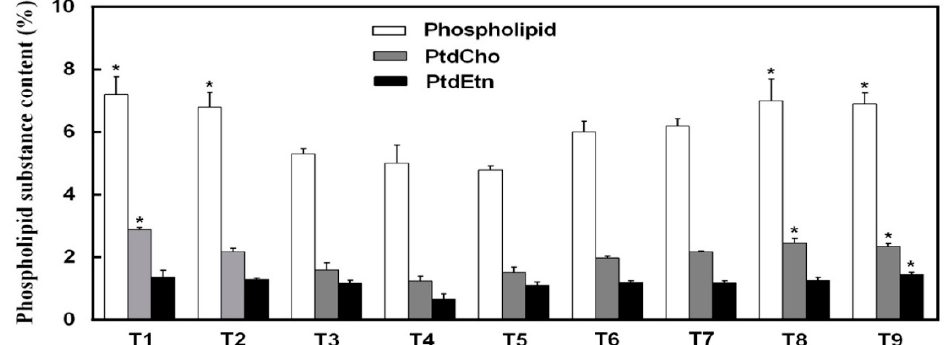
Figure 10. The contents of total phospholipids, phosphatidylcholine (PtdCho), and phosphatidylethanolamine (PtdEtn) in soybean grains of different stages of maturity. T1–T9 represents the samples of pods collected every 5 days starting from the 35th day after flowering. Symbol “*” indicates the significant difference at p value of 0.05.